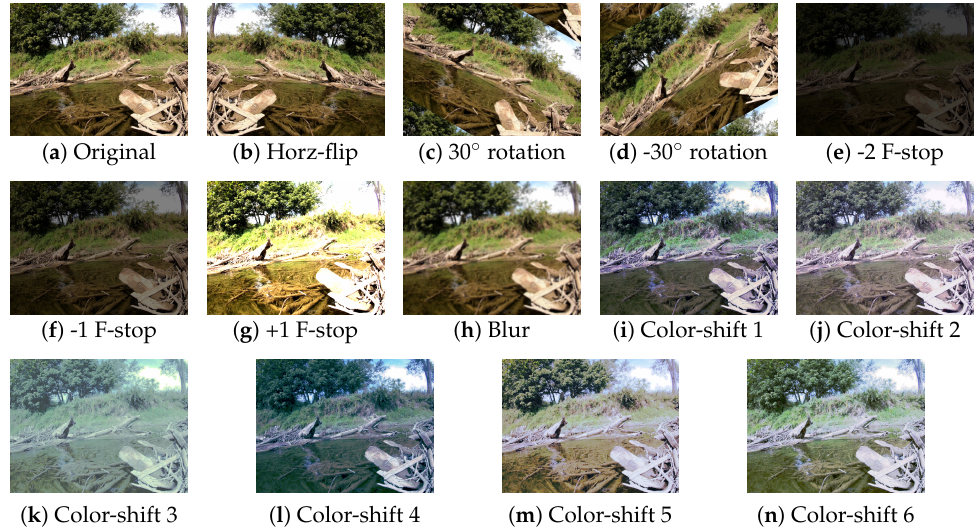
Figure 4. Each training image is augmented in 13 different ways as shown above. Example sequence uses images from Sugar Creek ROSEBUD Subset